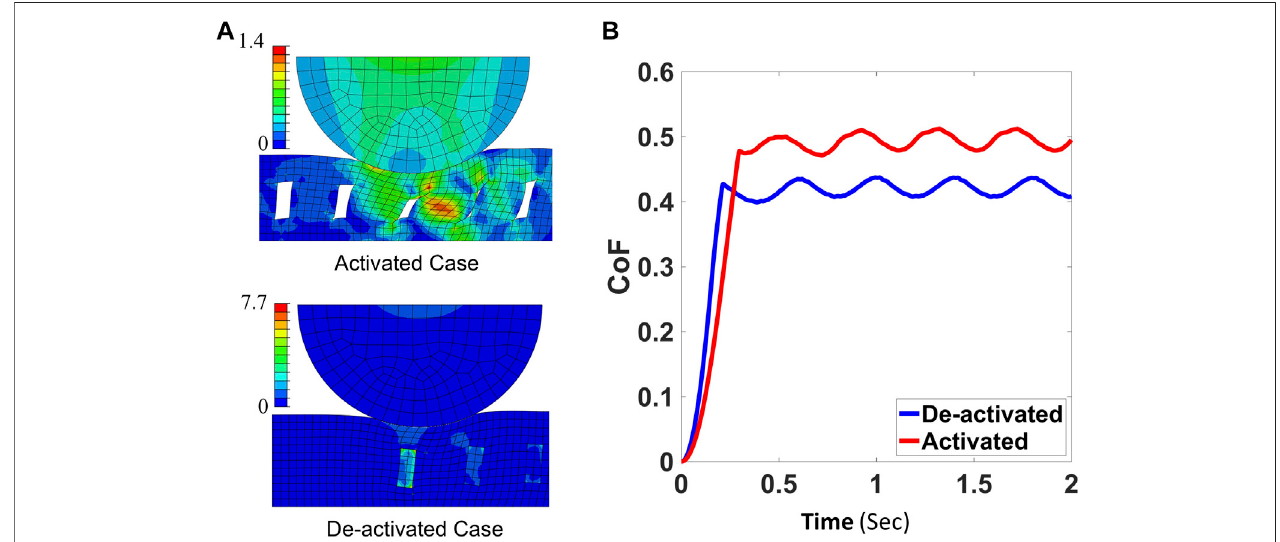
FIGURE 9 | (A) The deformation of the deactivated and activated pads under normal force 0.951 N. The color represents the Mises stress (MPa). (B) The CoFs of the deactivated and activated composite pads from simulations.